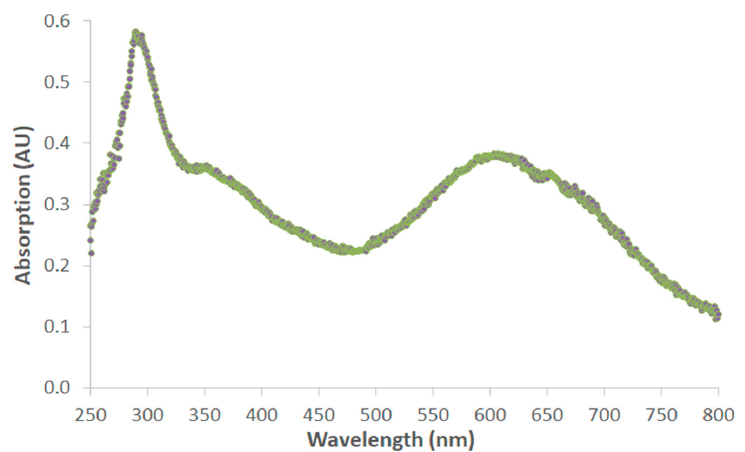
Figure 6. Absorption spectrum of benzodioxolyl-N-methylbutanamine (MBDB) dissolved in Marquis reagent with a concentration of 50 mM.